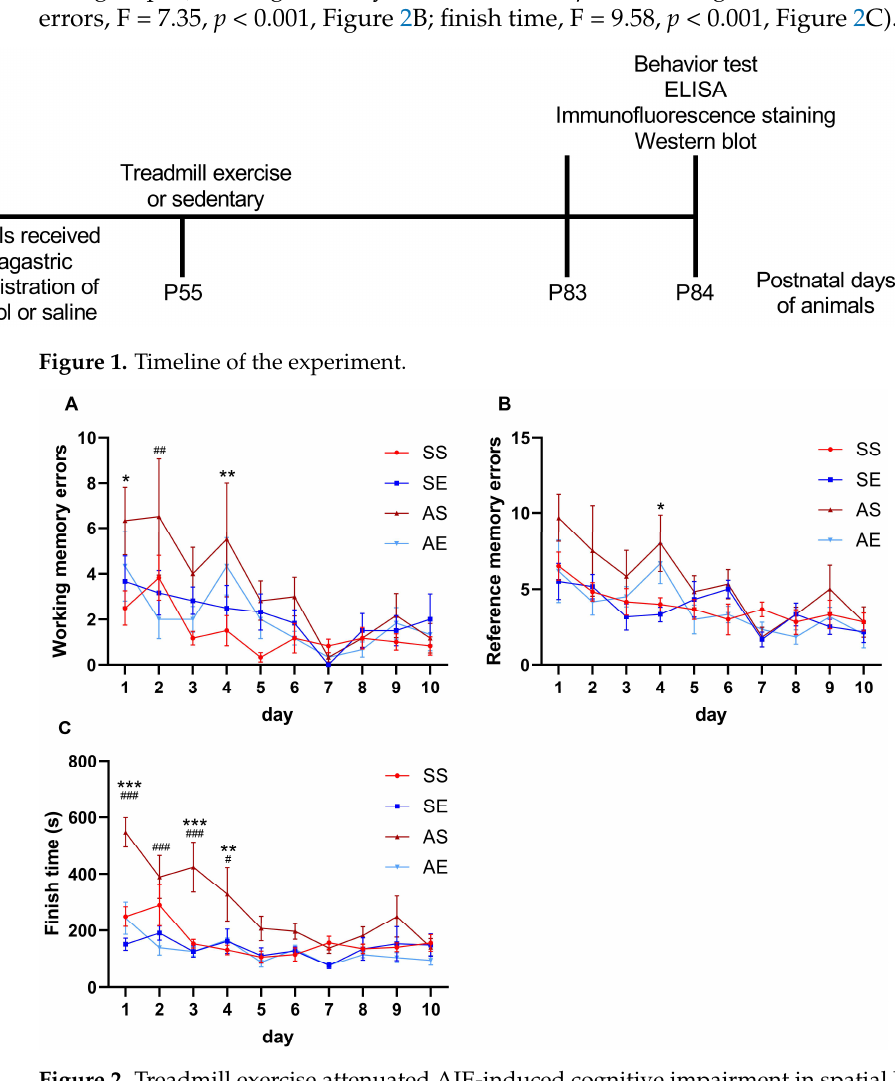
Figure 2. Treadmill exercise attenuated AIE-induced cognitive impairment in spatial learning and memory in young adult rats. ( A ) The working memory errors of rats in each group. The working memory errors on day 1 and day 4 were significantly increased in the AS rats compared to the SS rats. The working memory errors on day 2 were significantly decreased in AE rats compared to AS rats (* p < 0.05, SS vs. AS; ** p < 0.01, SS vs. AS; ## p < 0.01, AS vs. AE; n = 6). ( B ) The reference